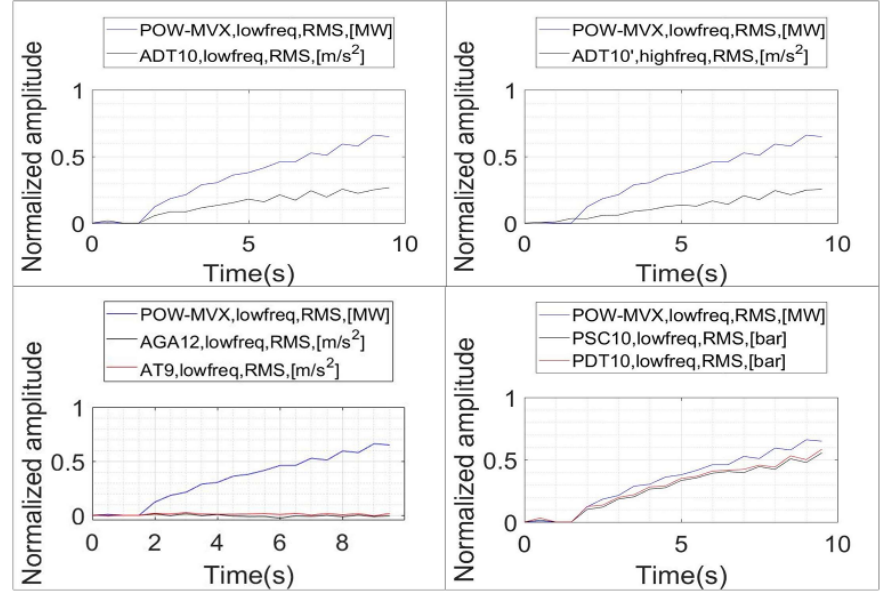
Figure 12. Evolution of the RMS indicators during the onset of the instability. Shifted trend according to initial